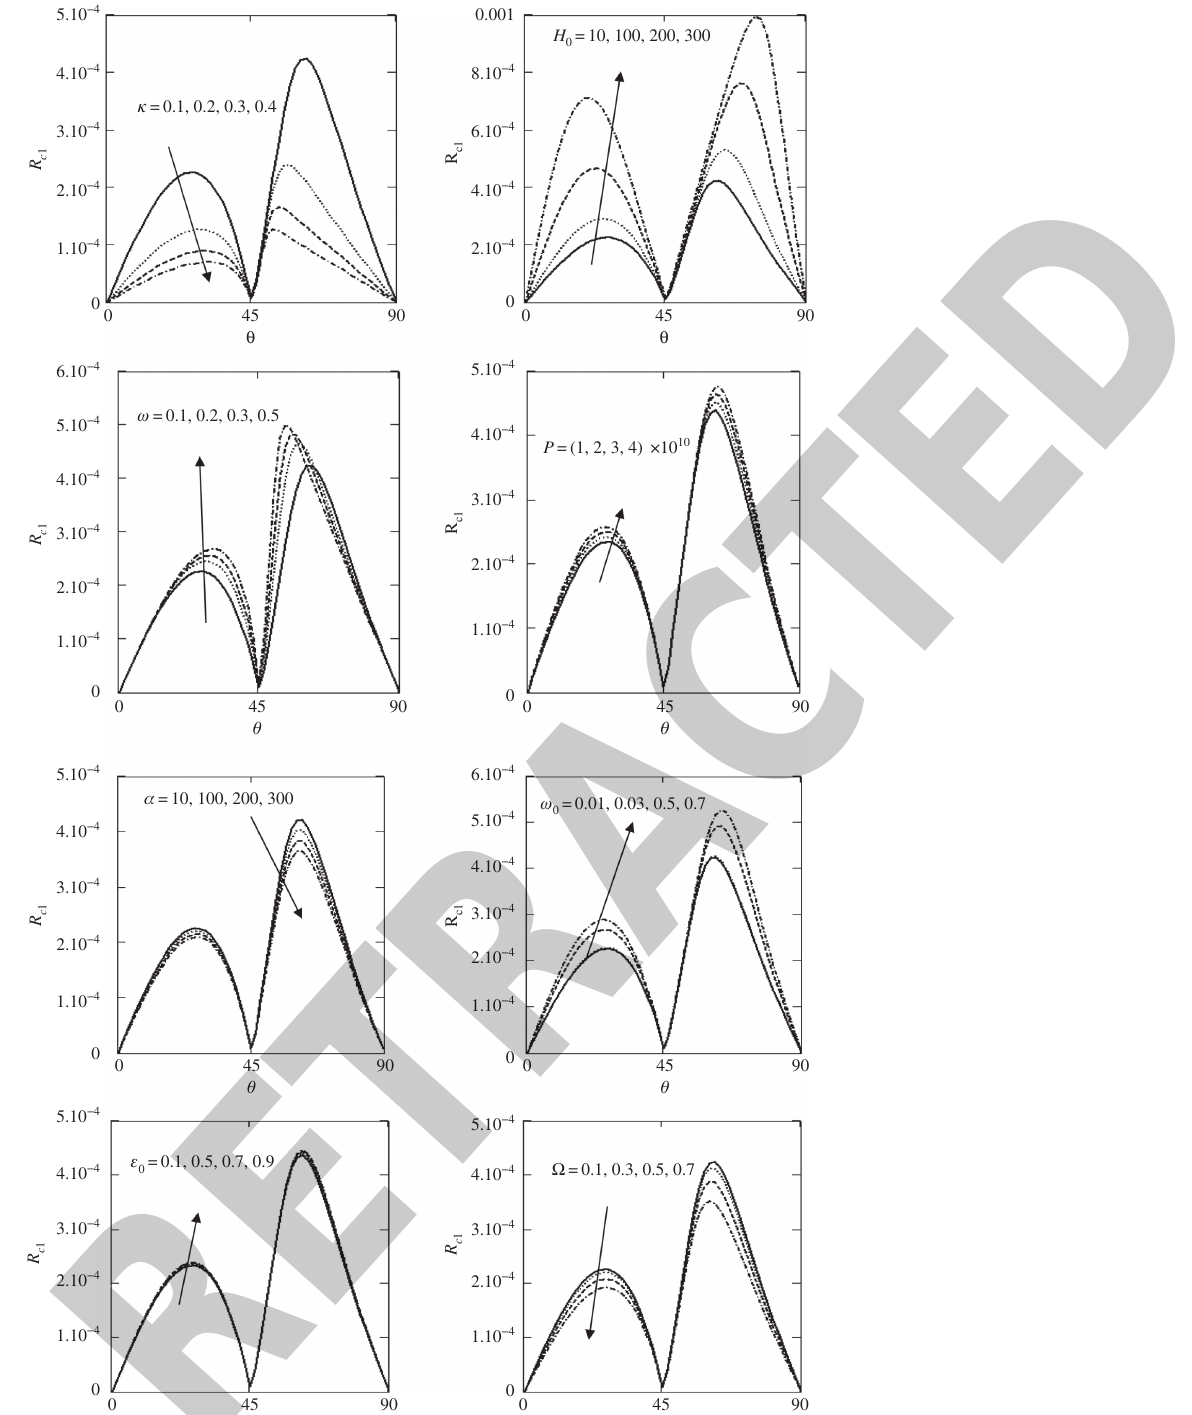
of the compressional (P) wave with variation of κ , H c1